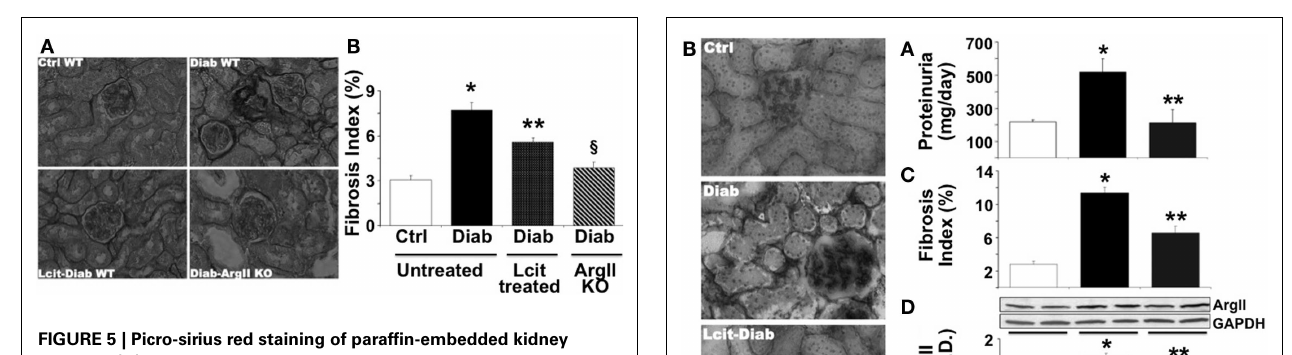
FIGURE 5 | Picro-sirius red staining of paraffin-embedded kidney sections . (A) Representative photomicrographs of picro-sirius red-stained kidney sections from untreated control wild type (CtrlWT), untreated diabetic wild type (DiabWT), L -cit-treated diabetic wild type (Lcit-DiabWT), and diabetic ArgII knock out (Diab-ArgII KO) mice at 16weeks (RGB image using Image J ). Increased collagen deposits (dark color) are observed in DiabWT.This effect was significantly reduced in Lcit-DiabWT, and in Diab-ArgII KO mice. (B) Fibrosis index (%) of tissue collagen content that indicates the ratio of the mean picro-sirius red-stained area to the mean whole area of the section.Values are mean ± SEM. * p < 0.001 vs. untreated CtrlWT, ** p < 0.01 vs. untreated Ctrl and DiabWT, § p < 0.001 vs. untreated DiabWT.